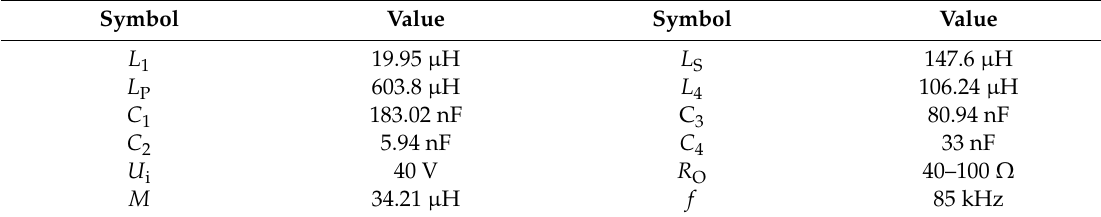
Table 1. System specification and parameter